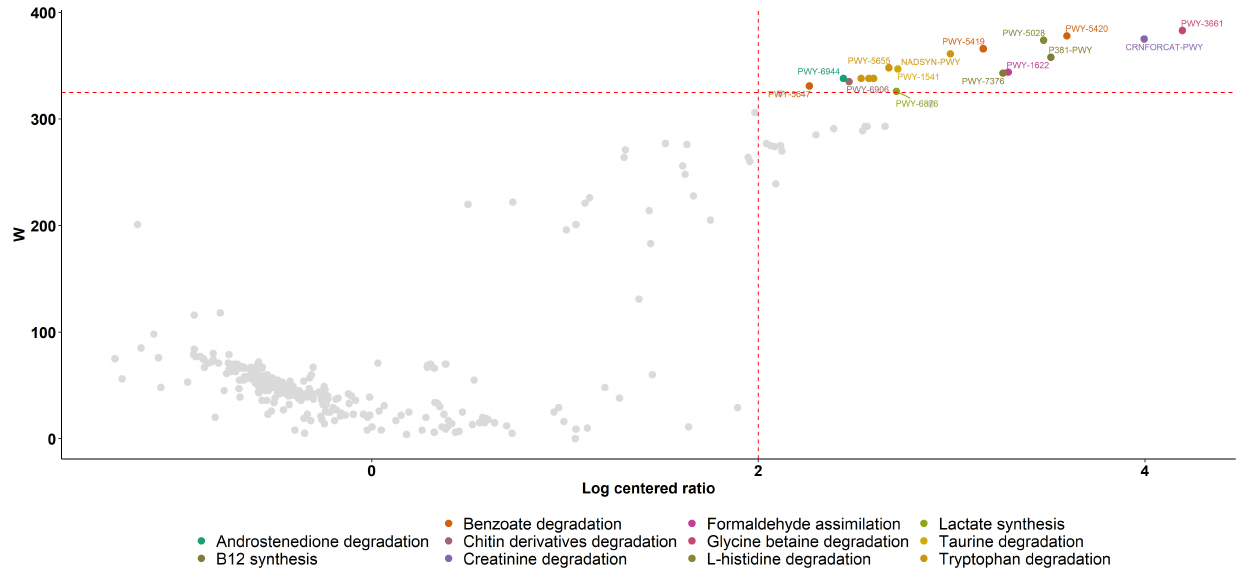
FIGURE 3 | Volcano Plot of PICRUSt analysis. Significant metabolic pathways down-regulated in the gut microbiota of individuals during the PCSI are represented in different colors with their corresponding MetaCyc ID. Metabolic pathways without a statistically significant difference between groups are shown in gray. The W -value represents the number of times the null-hypothesis (the average abundance of a given feature in a group is equal to that in the other group) was rejected for a given metabolic pathway. Red dash lines indicate a significance a priori threshold for differentially abundance set at W ≥ 324 ( W > 80% of the total number of metabolic pathways) and clr (centered logarithmic ratio) >